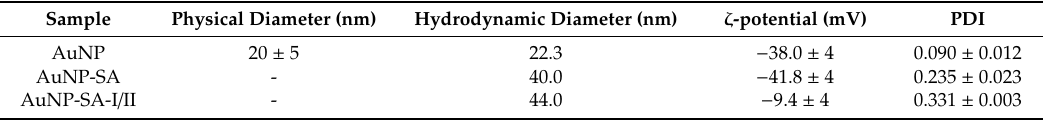
Table 2. Data from TEM (physical diameter), DLS (hydrodynamic diameter), and ζ -potential characterization of